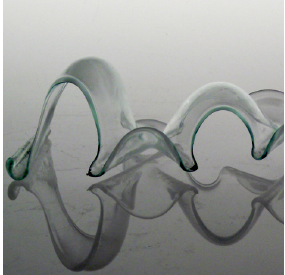
Figure 1: Pointly supported and deformed glass Figure 2: Linearly supported and deformed glass pane. pane.